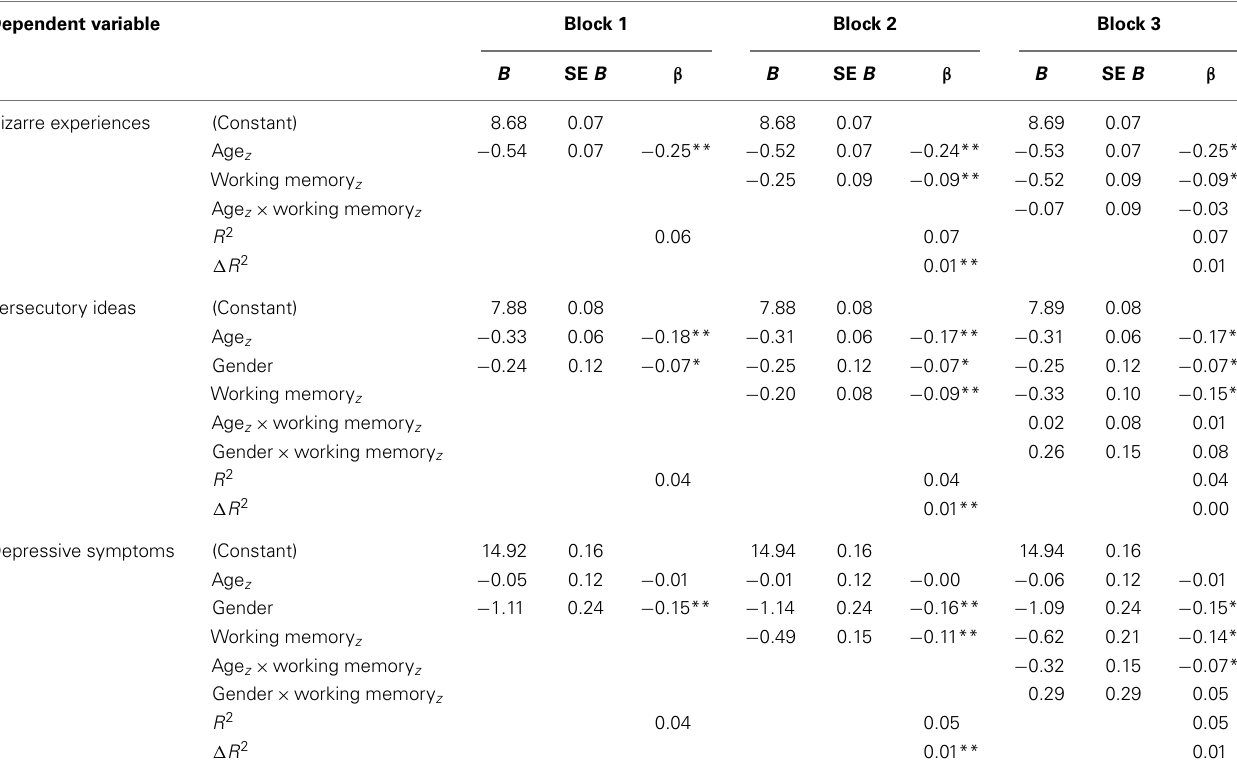
Table 5 | Regression models of symptom scores with working memory, age, and sex as predictors . Dependent